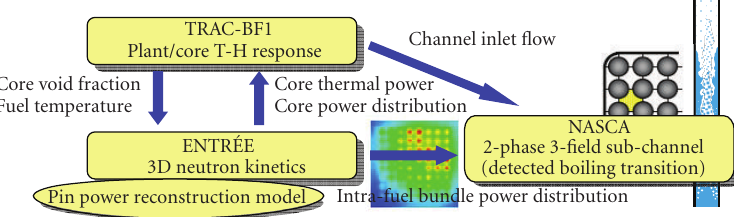
Figure 15: Outline of TRAC-BF1/ENTR´EE and NASCA code